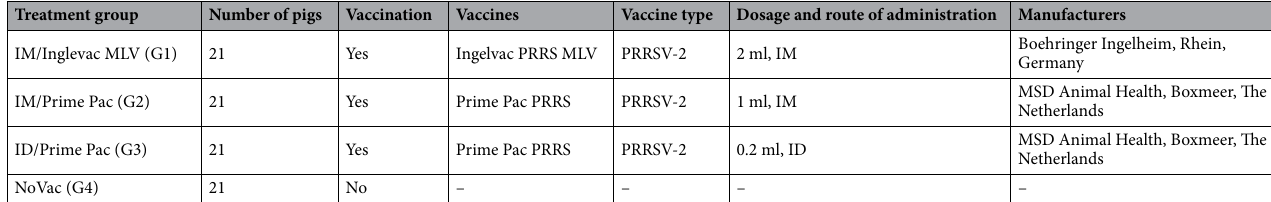
Table 1. Experimental design of experiment A (Exp A). Four treatment groups included 3 vaccinated groups and 1 non-vaccinated group. Routes of vaccine administration were included either intramuscular (IM) or intradermal (ID) using an IDAL